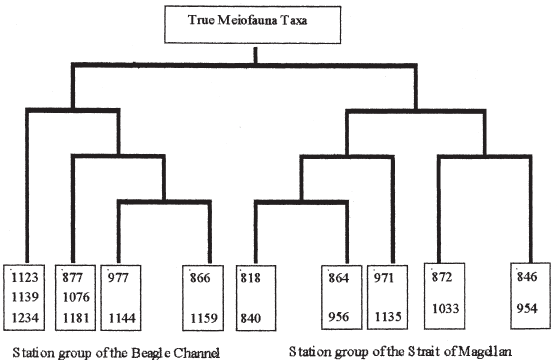
F IG . 3. – Dendrogram of TWINSPAN classification of the meiofauna communities in the Straits of Magellan and the Beagle Channel